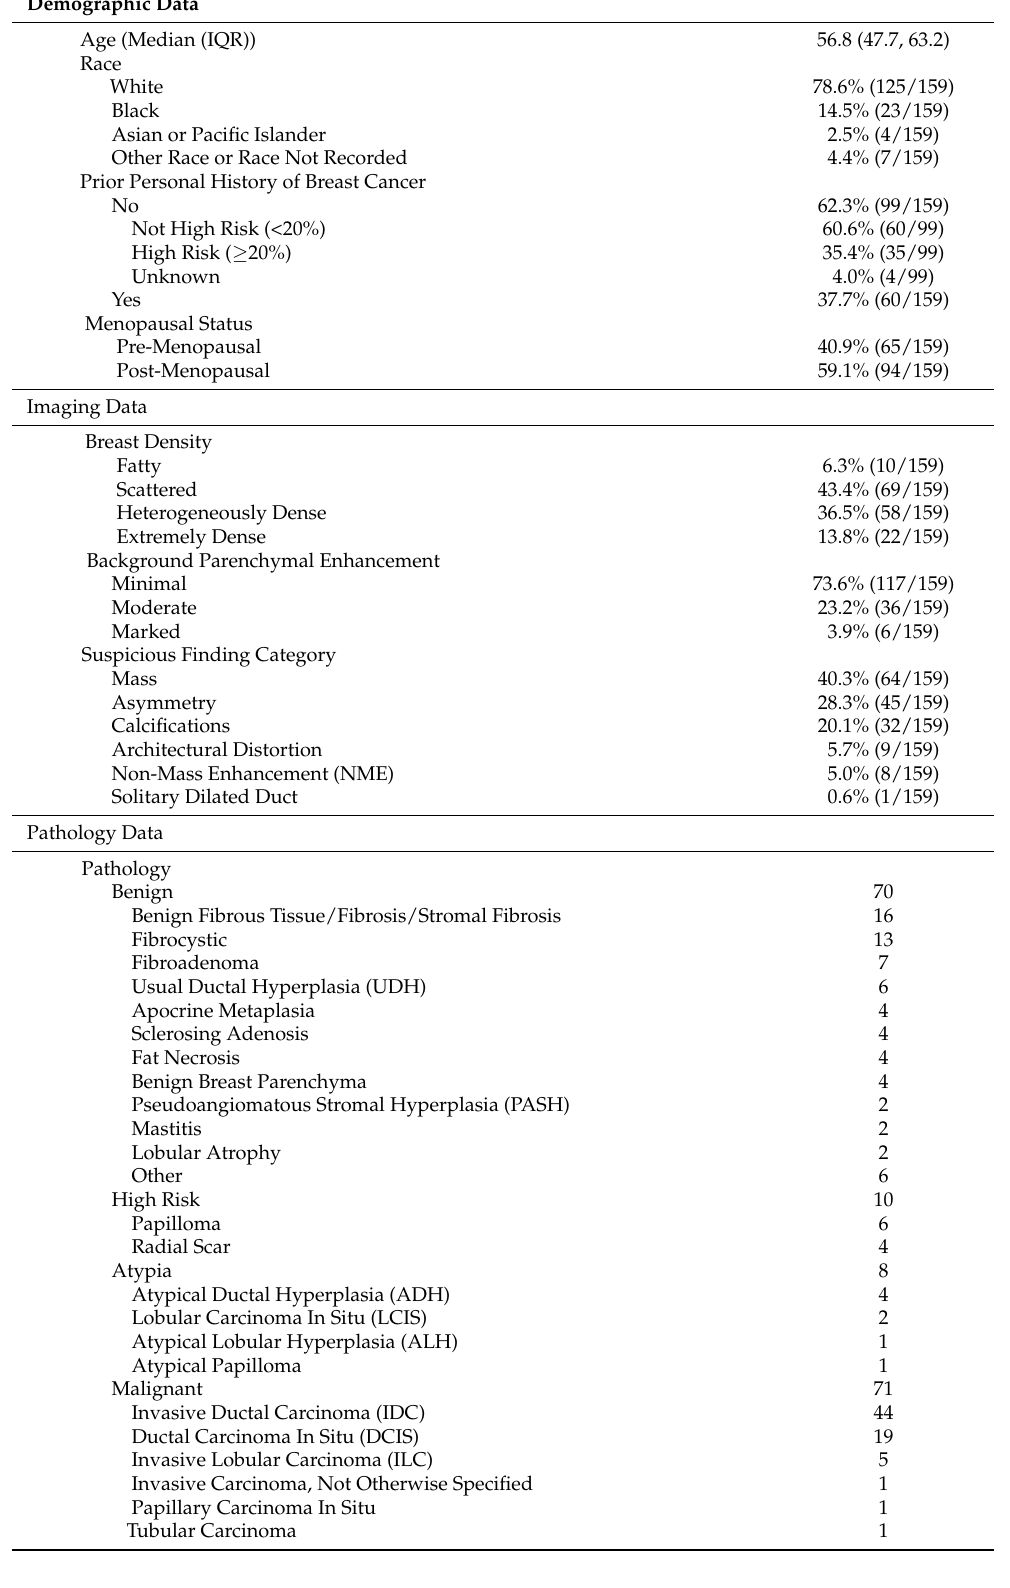
Table 1. Summary of demographic, imaging, and pathology data for all lesions detected on CEM ( n = 159). IQR: inter-quartile